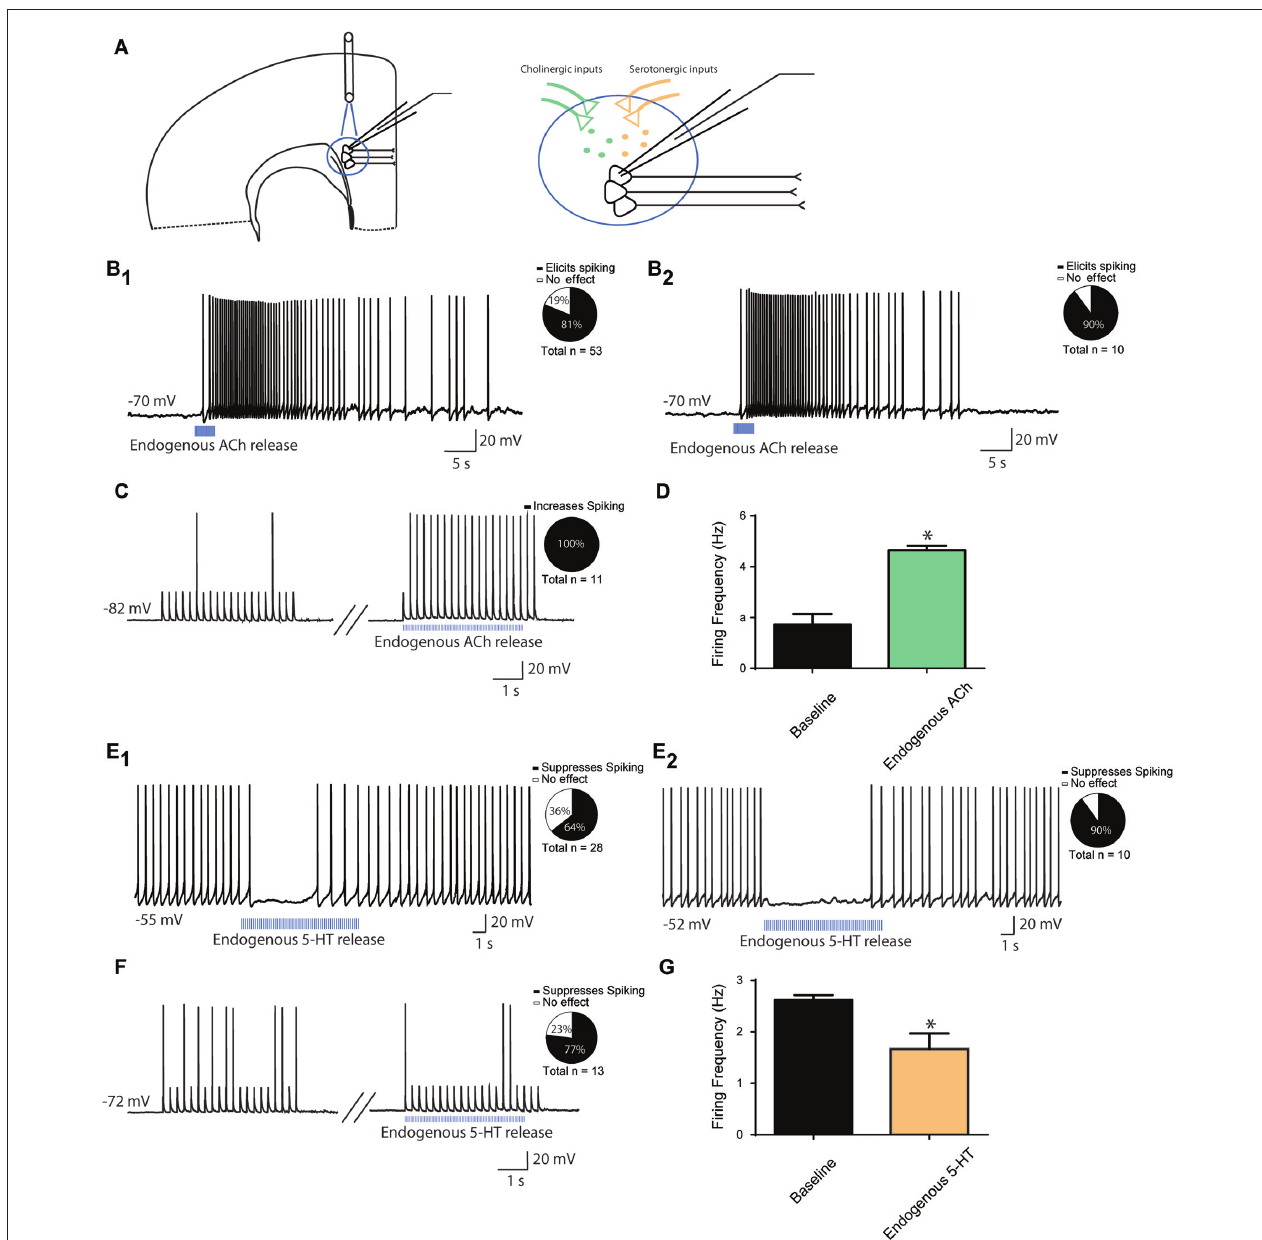
FIGURE 2 | Endogenous modulation of action potential firing in prefrontal layer 6 neurons. (A) Schematic diagram illustrating light-evoked ACh or 5-HT release onto layer 6 pyramidal neurons from presynaptic terminals. (B) A train of optogenetic stimuli (5 ms pulses, 10 Hz) to release ACh can elicit depolarization and action potential spiking in layer 6 neurons in cortical slices of mice with channelrhodopsin in axonal fibers from ChAT-expressing ACh neurons. For this experiment, neurons were injected with constant electrical current to bring them to a membrane potential of − 70 mV (B 1 ) . Pie chart illustrates that action potentials were elicited in 43/53 neurons. ACh-elicited action potential firing persisted in the presence of synaptic blockers CNQX, APV and picrotoxin (B 2 ) . Pie chart illustrates that action potentials were evoked in in 9/10 neurons. (C) In combination with a train of peri-threshold electrical pulses, optogenetic release of ACh increases the probability of action potential firing. Pie chart illustrates that action potential frequency was increased in 11/11 neurons. (D) Bar graph showing that spike frequency was significantly increased by optogenetic release of endogenous ACh ( t 10 = 6.9, p < 0.0001). (E) A train of optogenetic stimuli (5 ms pulses, 10 Hz) to release 5-HT can reduce action potential firing in layer 6 neurons in cortical slices of mice with channelrhodopsin in axonal fibers from Pet1cre-expressing 5-HT neurons (E 1 ) . For this experiment, neurons were injected with constant electrical current to bring them to spiking. Pie chart illustrates that action potentials were suppressed in 18/28 neurons. The 5-HT elicited suppression persisted in the presence of synaptic blockers CNQX, APV and picrotoxin (E 2 ) . Pie chart illustrates that action potentials were suppressed in 9/10 neurons. (F) In combination with a train of peri-threshold electrical pulses, optogenetic stimuli to release 5-HT decreases the probability of action potential firing. Pie chart illustrates that action potential frequency was decreased in 10/13 neurons. (G) Bar graph showing a small but significant decrease in spike frequency upon optogenetic release of 5-HT ( t 12 = 3.3, p = 0.007). ∗ Denotes p < 0.05.